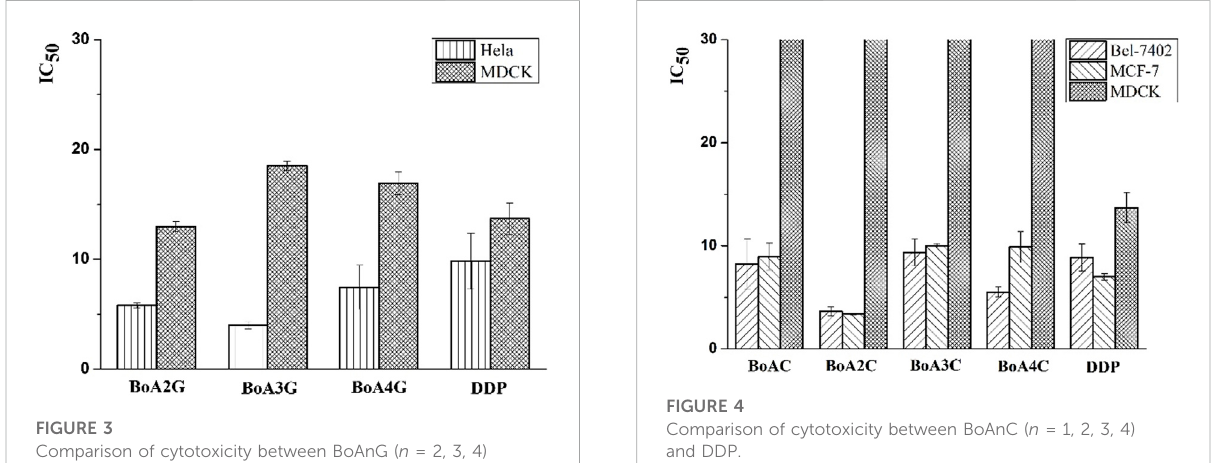
FIGURE 4 Comparison of cytotoxicity between BoAnC ( n = 1, 2, 3, 4) and